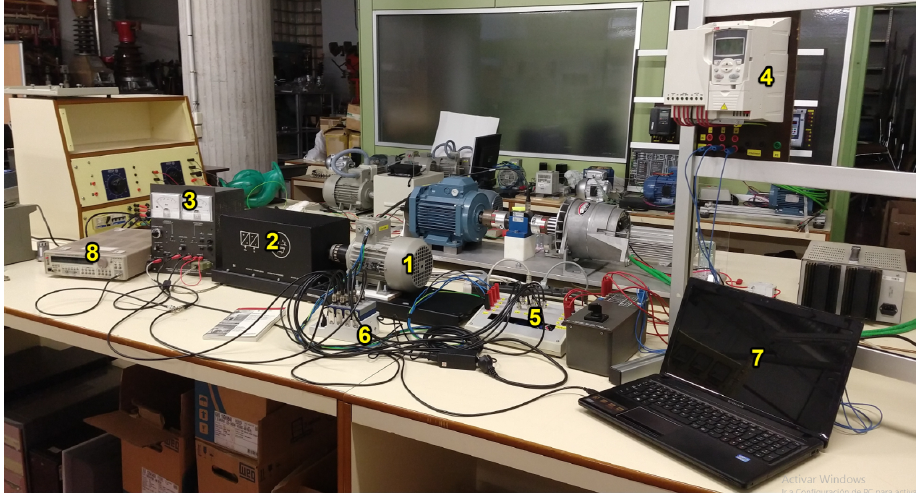
Figure 3. Experimental test ring configuration: (1) asynchronous motor, (2) electro-magnetic powder brake, (3) powder brake control, (4) voltage source inverter, (5) signal condition stage, (6) data acquisition system, (7) PC, and (8) programmable function